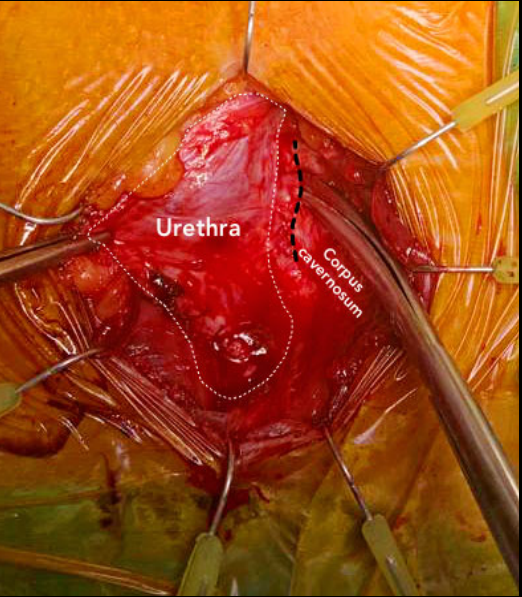
Figure 2. Right incision of the tunica albuginea of the corpora cavernosa 5 mm off the posterior attachment of the urethra to the corpora cavernosa.